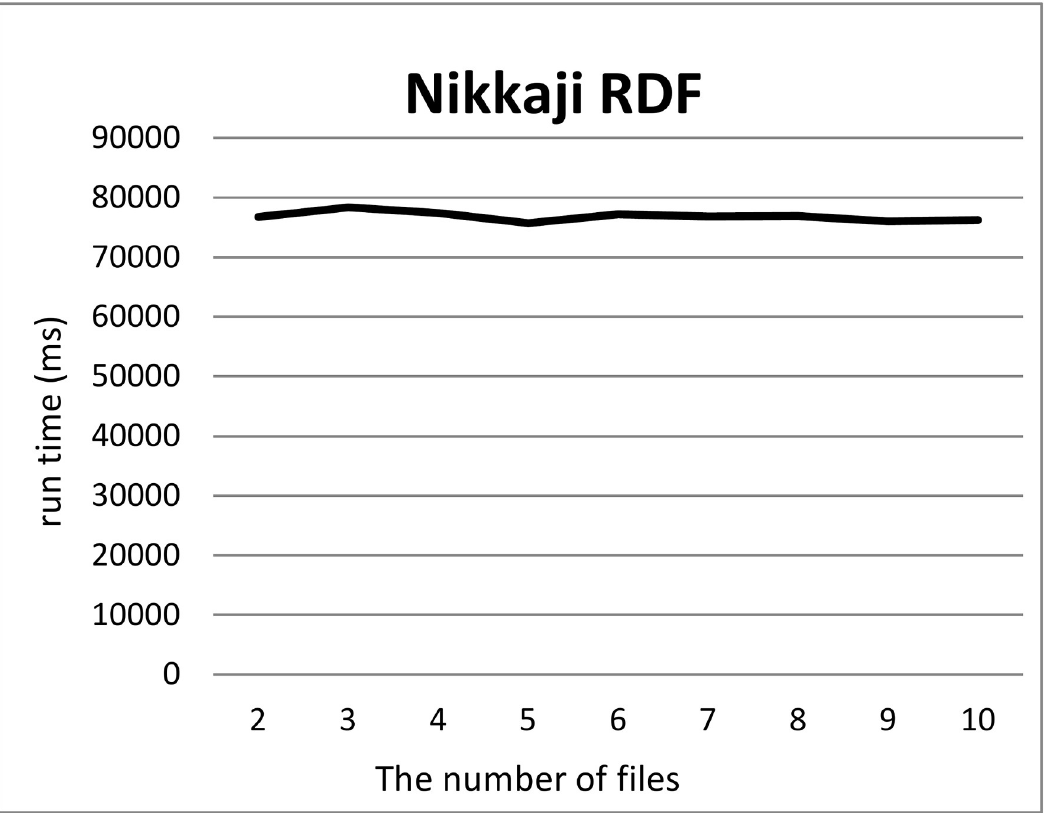
Fig 2. Computation time to split the Nikkaji dataset. x -axis and y -axis correspond to the number of files from two to ten and the average of running time [ms], respectively.